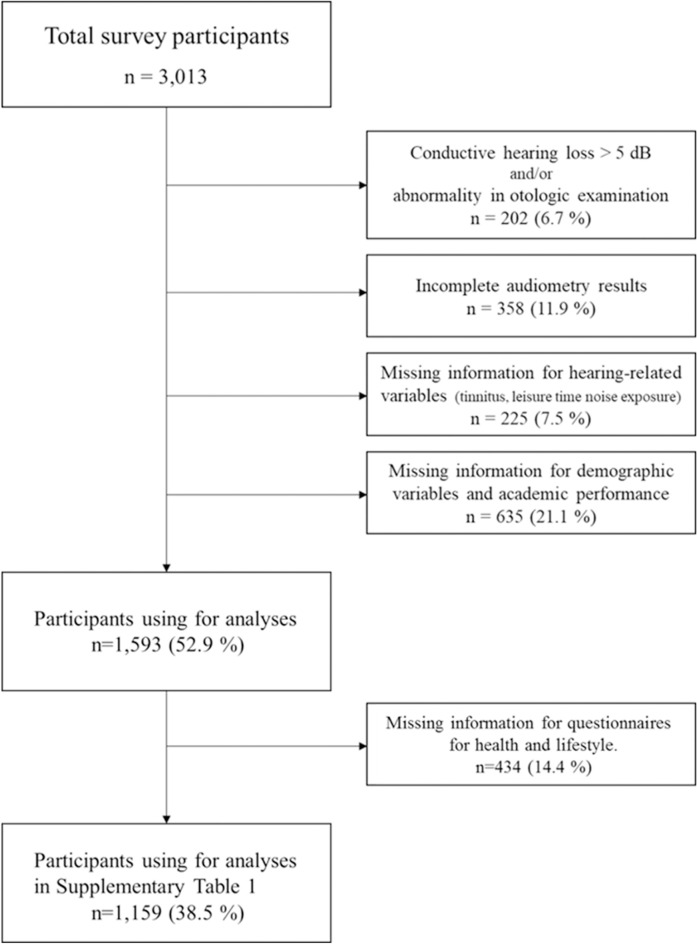
Flow chart of selection of the subjects.